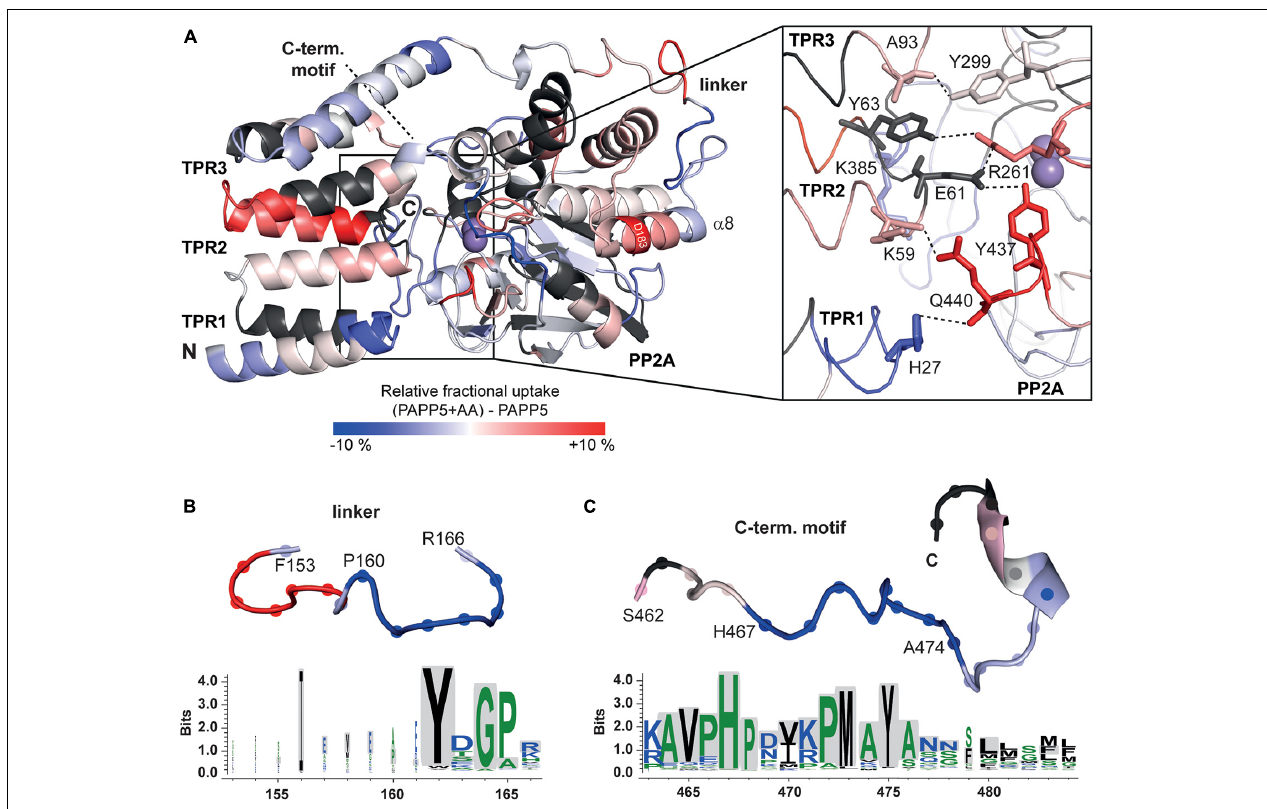
FIGURE 6 | HDX-MS analysis of At PAPP5 in blue-white-red representation. (A) The difference in deuterium uptake between At PAPP5 alone and in the presence of arachidonic acid after 15 s. Regions in red show an increased uptake, while blue structural features represent a reduced exchange rate due to interaction with AA. (A) The magnification shows the residues involved in the interaction between TPR and PP2A domains colored according to their uptake. (B,C) The linker and the C-terminal motif show both a decreased deuterium uptake compared to the rest of the structure. The conservation of this regions within the PP5 family was generated using the server Weblogo 3.0 (Schneider and Stephens, 1990; Crooks et al., 2004) (using 60 ortholog sequences with a pairwise sequence identity of < 90%). The height of the letters represents the degree of conservation and gray shading marks the sequence of At